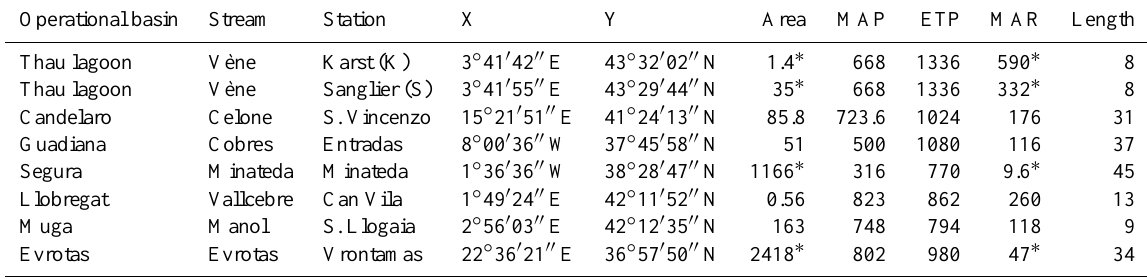
Table 1. Main characteristics of the studied basins. Catchment area in km 2 ; MAP=mean annual precipitation (mm); ETP=mean annual reference evapotranspiration (mm); MAR=mean annual runoff (mm), Length=available record length in years.